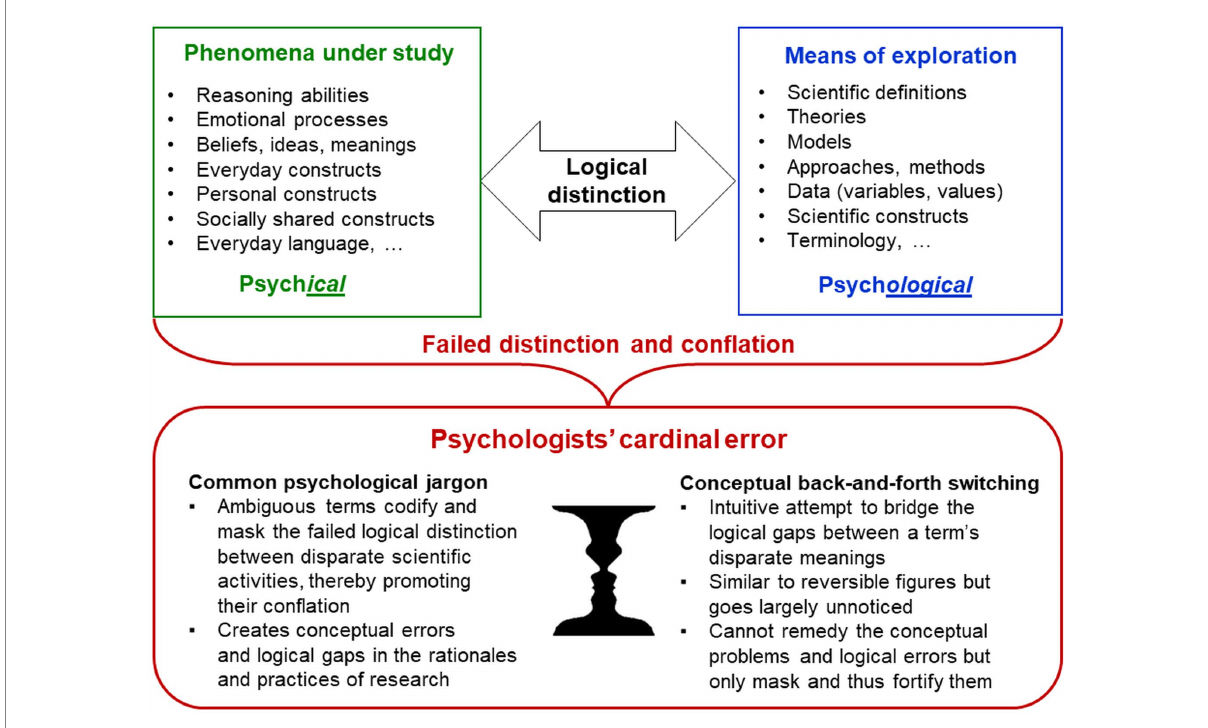
FIGURE 2 Psychologists’ cardinal error. Abilities of the human mind are essential for any science; empirical research is experience-based by definition. This complicates for psychologists the logical distinction of their study phenomena from their means of exploring these phenomena, which are therefore often conflated— psychologists’ cardinal error . Researchers’ intuitive conceptual back-and-forth switching between the different meanings that are being conflated masks the logical gaps created and hinders the recognition of these conceptual